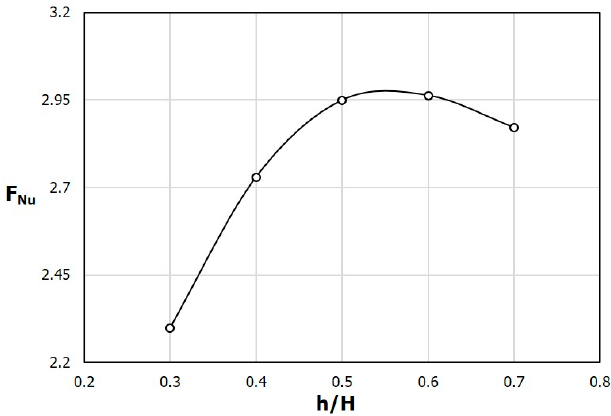
Figure 5. Variation of the performance parameter related to heat transfer (F Nu ) with the ratio of the rib height to the channel height (h/H) (the ratio of the rib width to the channel width (e/W) = 0.1).